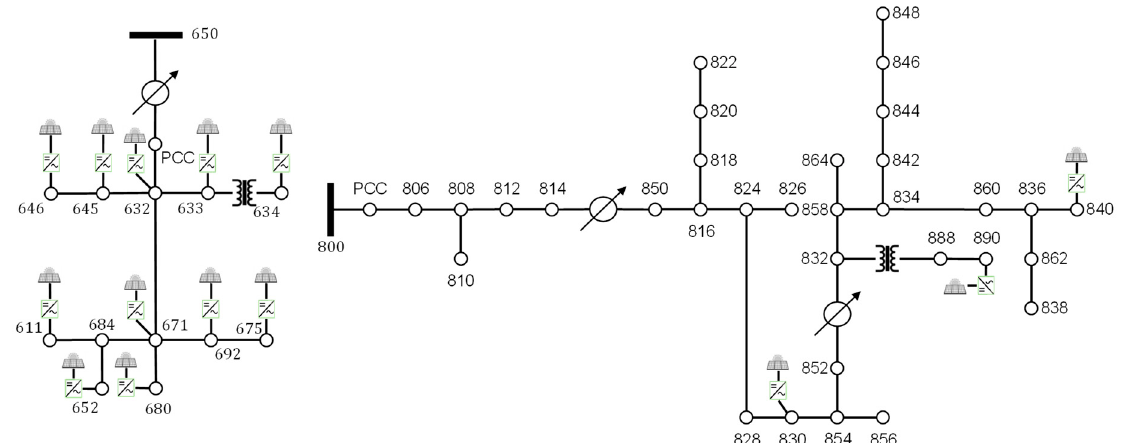
Figure 8. Modified IEEE 13 bus system ( left ) and IEEE 34 bus system ( right ) in a single-line diagram.